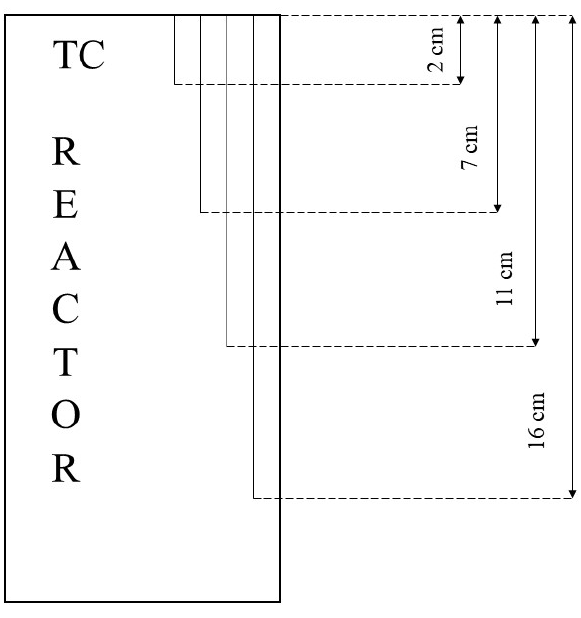
Figure 1. Thermocouples placement inside the reactor.